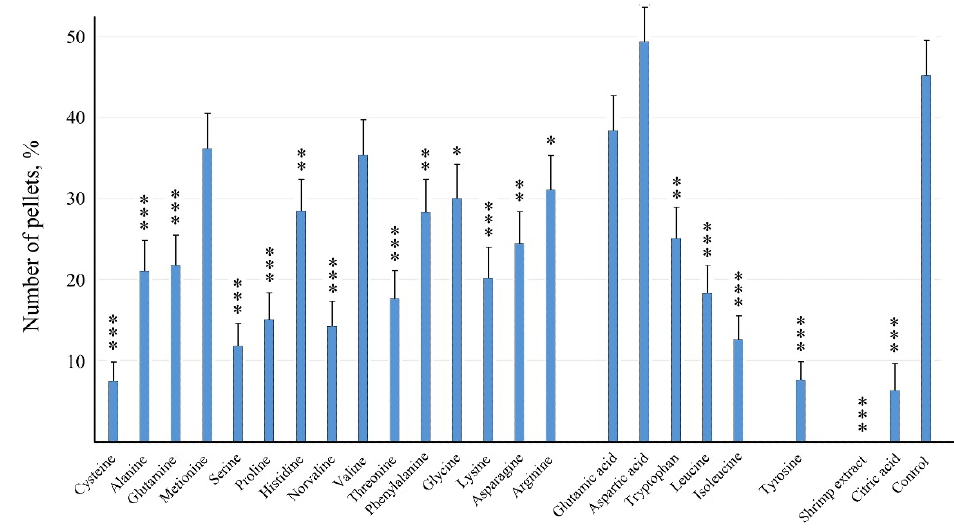
Figure 6. Fragmentation of agar gel (2%) pellets flavored with amino acids in barramundi Lates cal ‐ carifer juveniles. *, ** and ***—differences from the control are significant at p < 0.05, p < 0.01, and p < 0.001, respectively ( χ 2 ‐ test). Whiskers are the s.e.m.